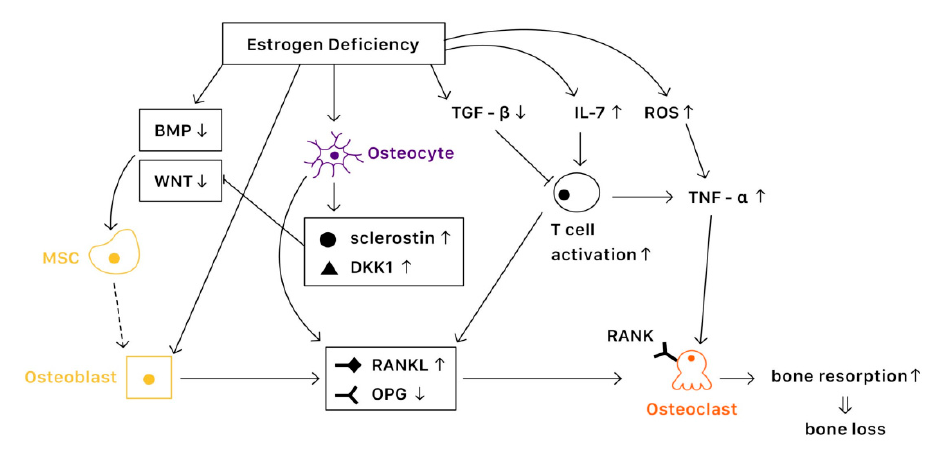
Figure 2. The mechanisms of estrogen deficiency related osteoporosis